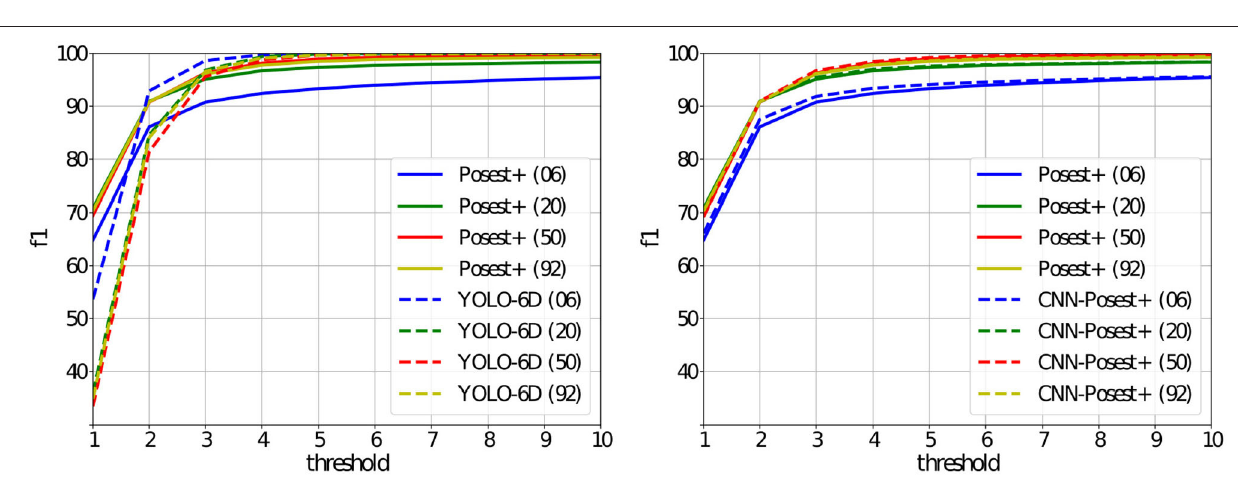
Frontiers in Virtual Reality |